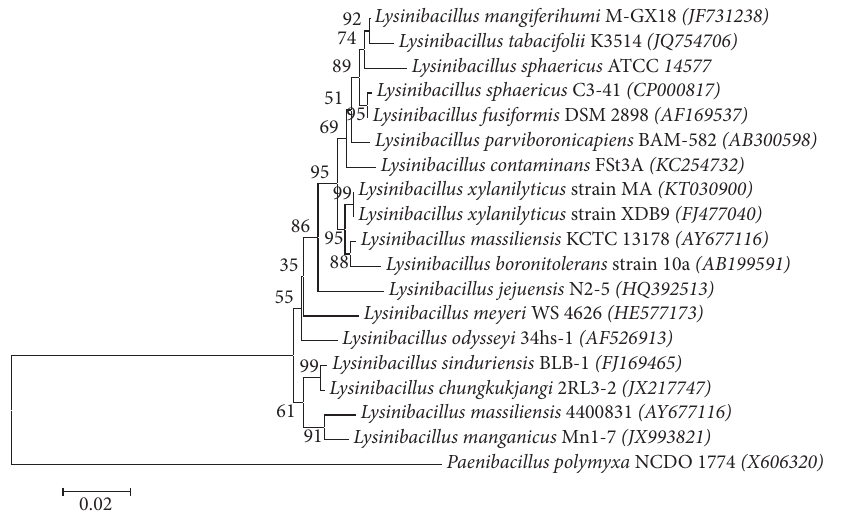
Figure 1: Neighbor-joining tree of Lysinibacillus xylanilyticus strain MA based on the 16S rRNA gene sequences.